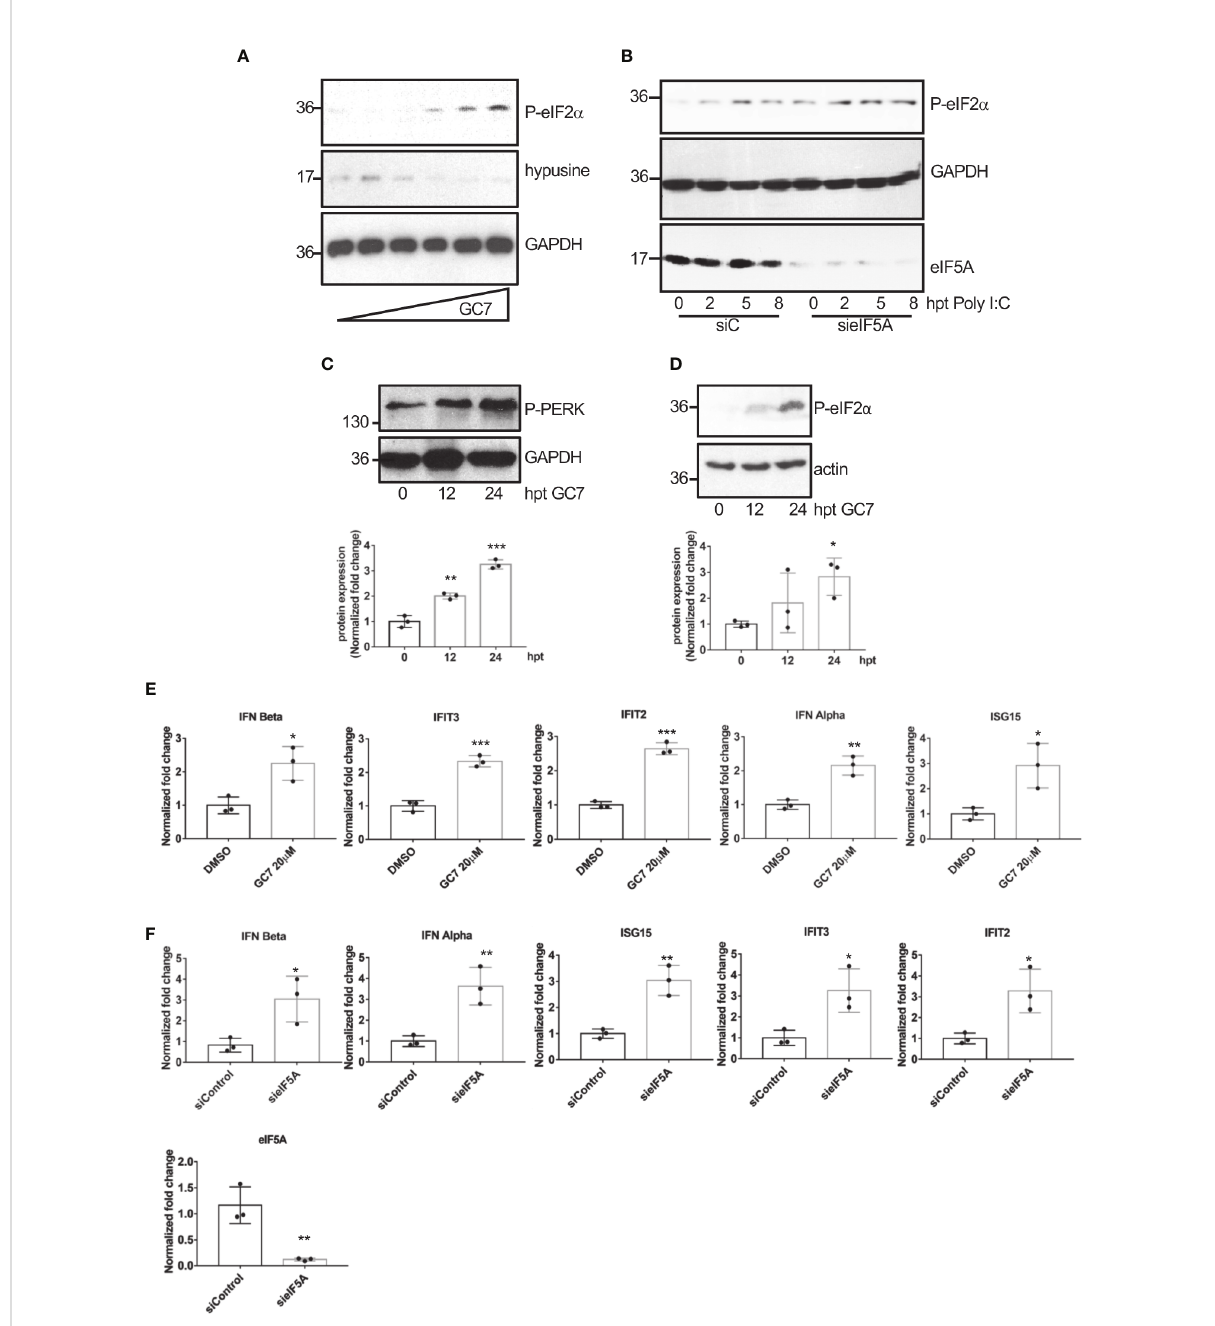
FIGURE 7 Induction of eIF2a phosphorylation and of interferon-stimulated gene expression after hypusination inhibition or eIF5A downmodulation. (A) , Induction of eIF2 a phosphorylation after treatment with increasing dose of GC7. (B) , Upregulation in eIF2 a phosphorylated levels after poly I:C transfection in A549 cells transfected with on-target plus non-targeting siRNAs (siC) or smart-pool small interfering RNAs (siRNAs) against eIF5A1 (sieIF5A). Induction of PERK (C) and eIF2 a (D) phosphorylation at different times after GC7 treatment. Phosphorylated protein band intensity was measured and normalized to GAPDH or actin band intensity. Data represent the mean and error bars of three biological replicates (lower panels). Statistical analysis was assessed by a Student ’ s t-test. *, P<0.05; **, P< 0.005; ***, P< 0.0005. Expression of IFN and IFN-stimulated transcripts in A549 cells treated with GC7 for 24 h (E) or in A549 cells transfected with siC or sieIF5A1 (sieIF5A) for 72 h (F) was quanti fi ed by real-time RT-PCR and represented as fold induction over untreated cells. Data represent the mean and error bars of three biological replicates. Statistical analysis was assessed by a Student ’ s t-test. *, P<0.05; **,